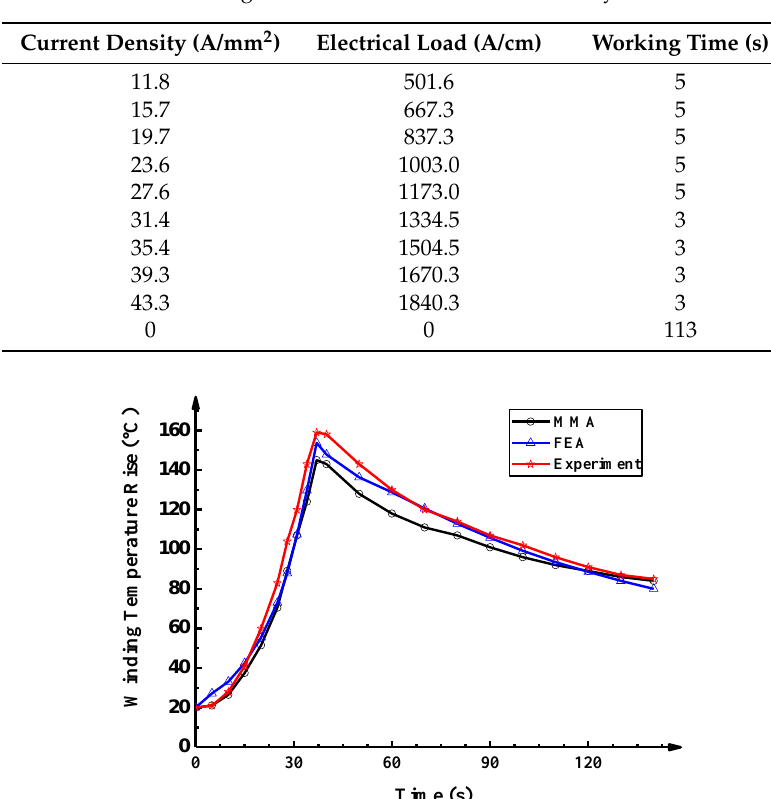
Table 3. Working time under different current density condition.